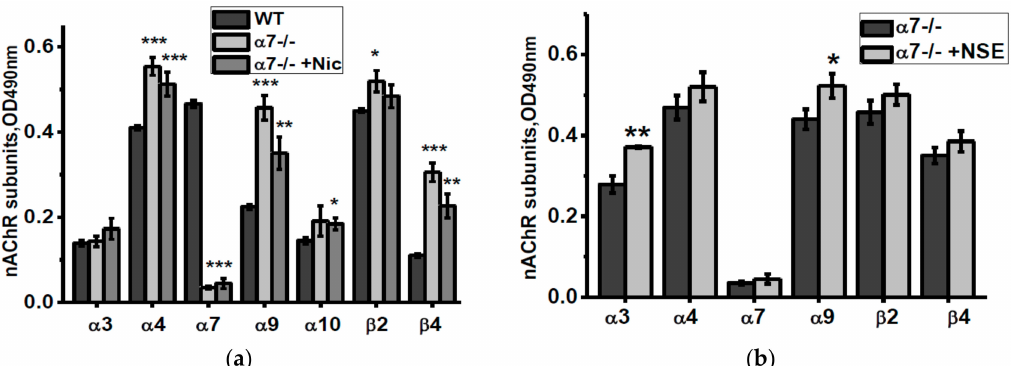
Figure 6. nAChR subunits composition in the brain mitochondria of α 7- / - mice under the e ff ect of either nicotine ( a ) or NSE ( b ). Each column corresponds to M ± SD, n-5. * p < 0.05; ** p < 0.005; *** p < 0.0005 compared to non-treated WT mice ( a ) or α 7- / - mice ( b